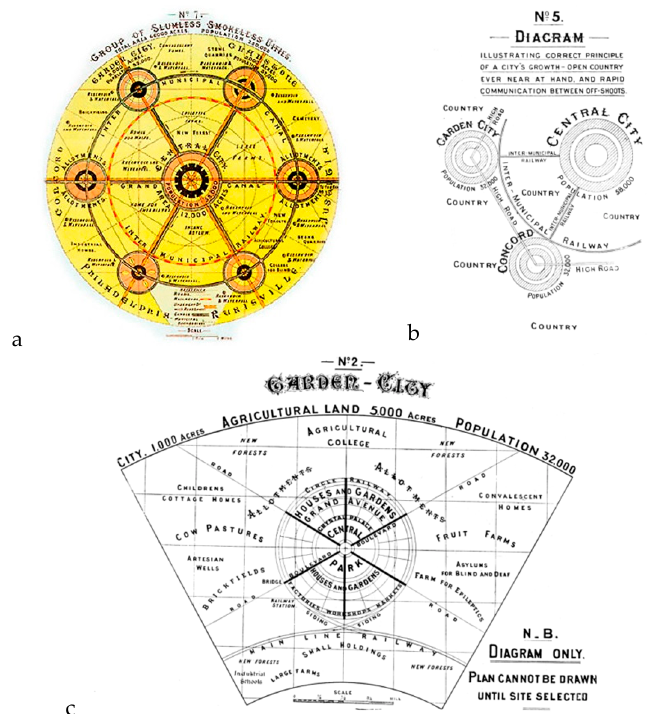
Figure 6. The Garden City Model (by E. Howard): ( a ) Garden city scheme